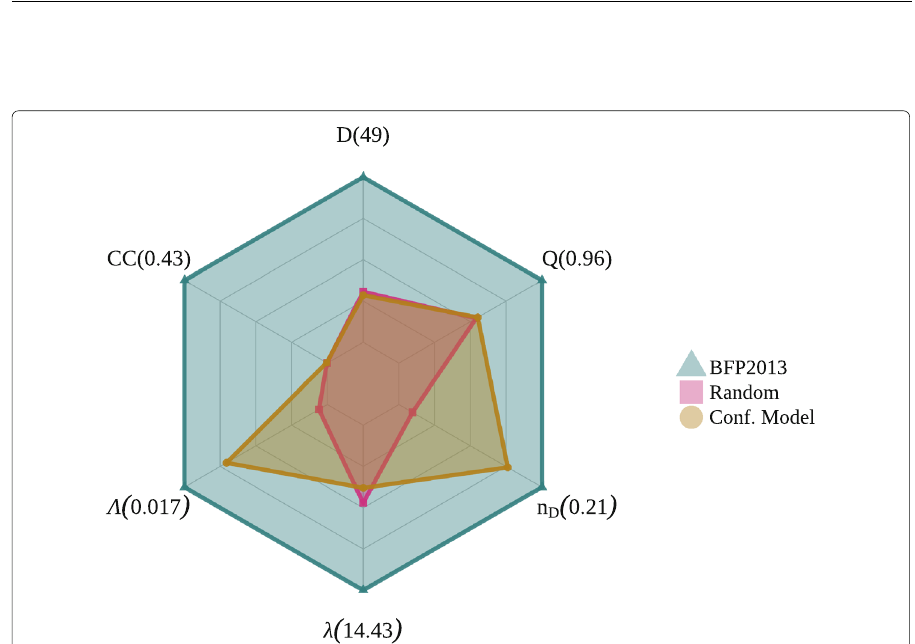
Fig. 2 Radar chart displaying network parameters for the BFP2013 network (blue pattern and triangle symbols), its randomized counterpart (red pattern and square symbols), and the corresponding configuration model (yellow pattern and round symbol). Data for BFP2013, randomized, and configuration model networks, in this order, are the following: diameter ( D = 49,15,14), average shortest path length ( λ = 14.43,6.78,5.48), assortativity ( (cid:6) = 0.017,0.001,0.012), average clustering coefficient ( < CC > = 0.430,0.001,0.002), modularity ( Q = 0.96,0.52,0.53) and number of driver nodes ( n D =